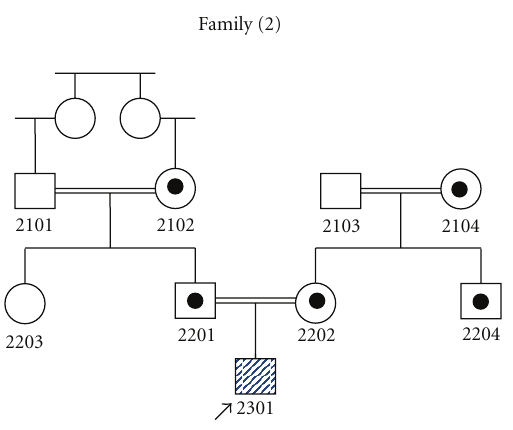
Figure 4: Pedigree of family (2) showing the genotyping of all individuals regarding c.776-1G > C mutation found in the proband (assigned by an arrow), pointed circles and squares are healthy carriers for the mutation while empty circles and squares are healthy individuals tested negative for this